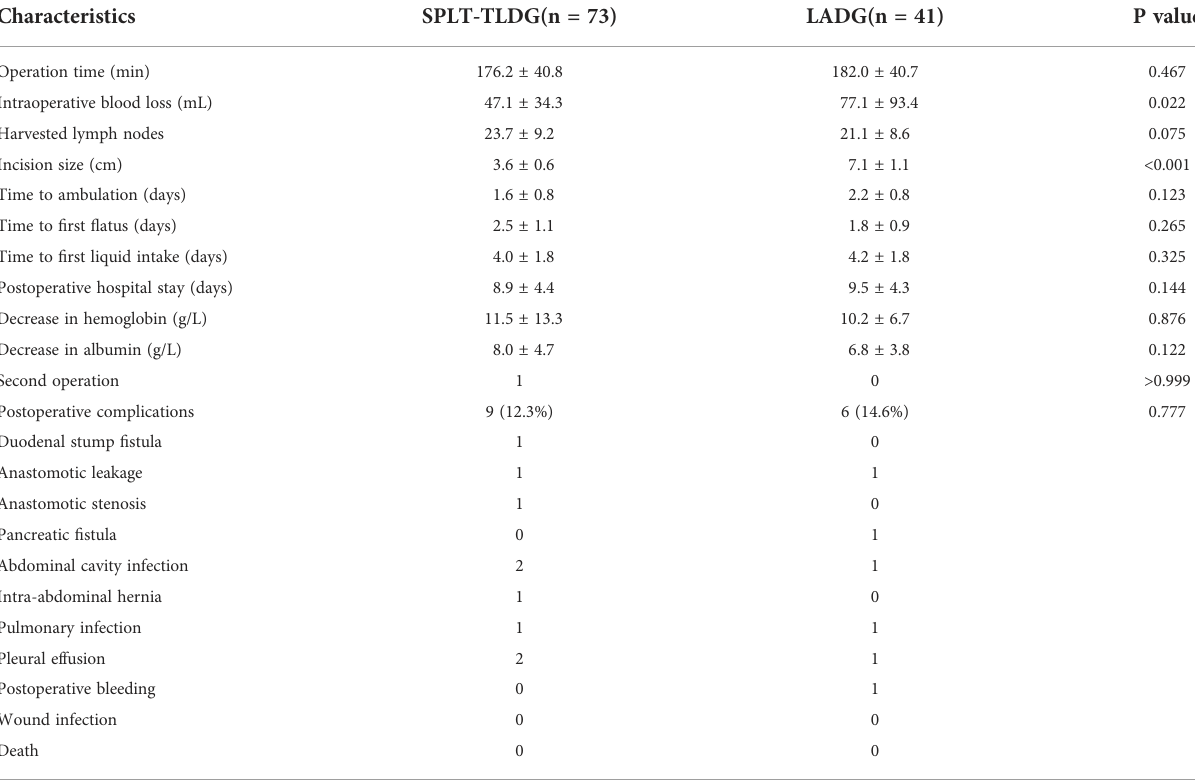
TABLE 2 Comparison of surgical outcomes between SPLT-TLDG and LADG.